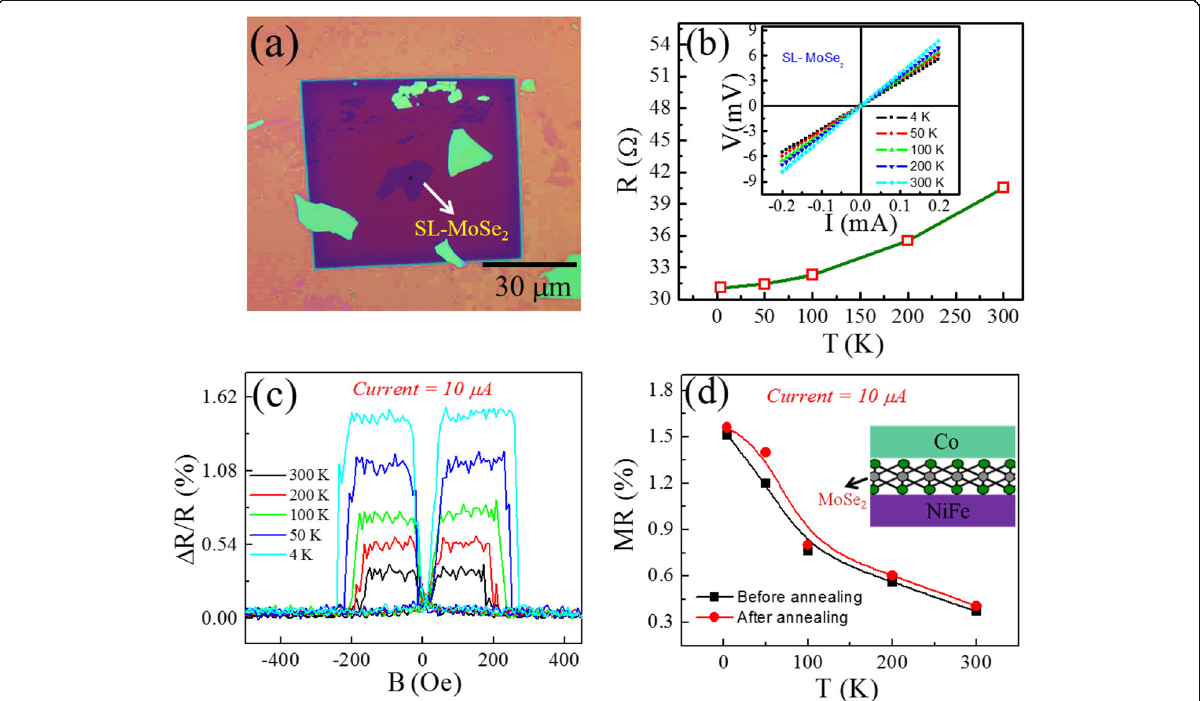
Fig. 2 a Optical image of SL-MoSe 2 flake on top of the hole. b Junction resistance of SL-MoSe 2 at different temperatures. (Inset) Temperature- dependent I - V curves of vertical Co/SL-MoSe 2 /NiFe SVJ demonstrates a metallic junction. c The variation of R vs B at T = 300, 200, 100, 50, and 4K before annealing. d The temperature-dependent MR ratio of Co/SL-MoSe 2 /NiFe before and after annealing at fixed current. (Inset) The schematic illustration of the device with SL-MoSe